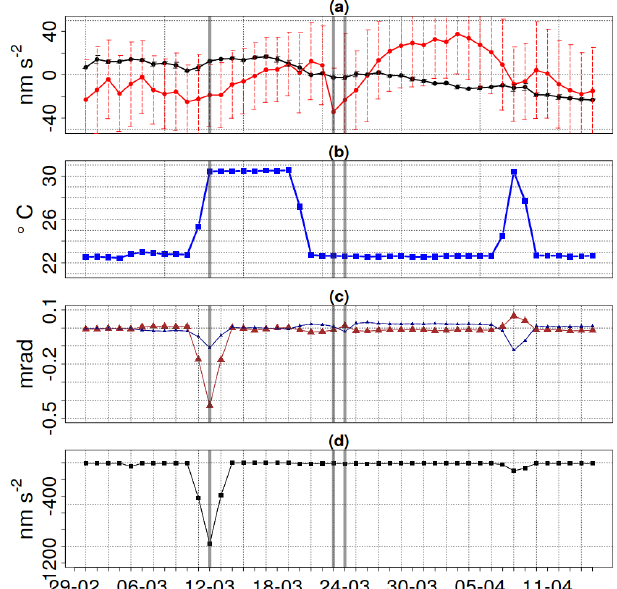
Figure 6. (a) Residuals of g for the iGrav-002 (black) and AQG- B01(red). (b) External temperature (blue). (c) Tilts in x (brown) and y (dark blue) for the tests 3 and 4 in March and April 2020 (see Fig. 1 for the timeline). (d) Tilt correction combined for x and y in nms − 2 . Dates marked as grey were subject to further instrument tests and